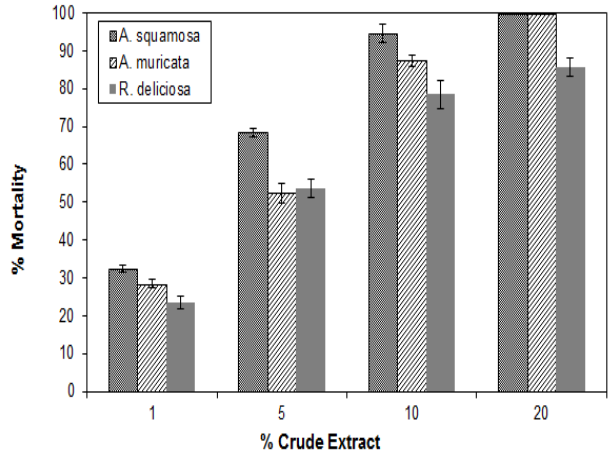
Fig. 1 . Mortality of C. gestroi in no choice feeding with crude Annona seed extracts after 14 days of